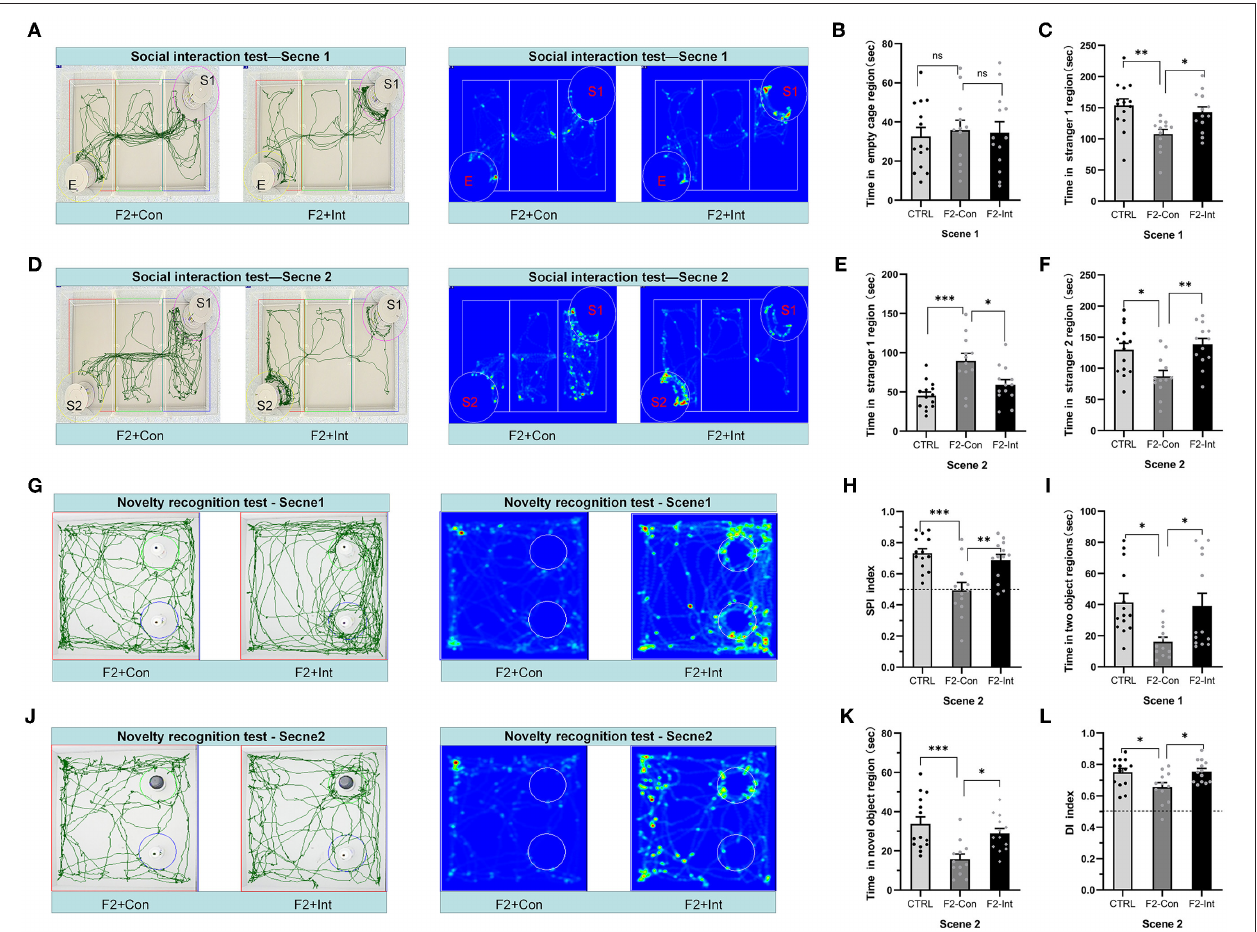
FIGURE 4 | Prenatal baclofen administration corrected social interaction deficits and novelty recognition deficits in F2 mice in the social interaction test. (A,D) In the social interaction test, representative traces and heatmaps from tested mice in the sociability phase (scene 1) and preference for social novelty phase (scene 2). (B) The time that tested mice entered the region of empty cage for sniffing in scene 1 of the social interaction test. (C) The time that tested mice entered the region containing stranger 1 for sniffing in scene 1 of the social interaction test. (E) The time that tested mice entered the region containing stranger 1 for sniffing in scene 2 of the social interaction test. (F) The time that tested mice entered the region containing stranger 2 for sniffing in scene 2 of the social interaction test. (G,J) Representative traces of tested mice in the novel object recognition task. (G) Traces and heatmaps of mice exploring the regions containing the two similar